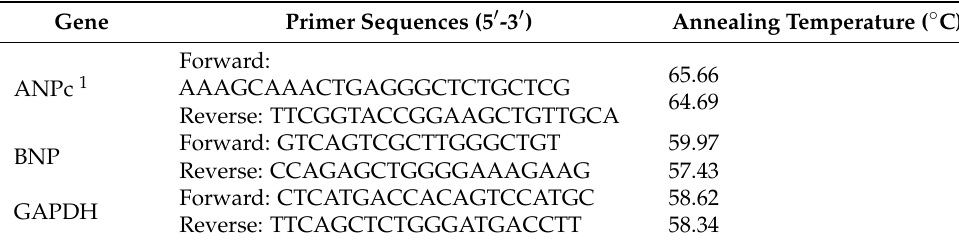
Table 1. Sequence of primers for real-time